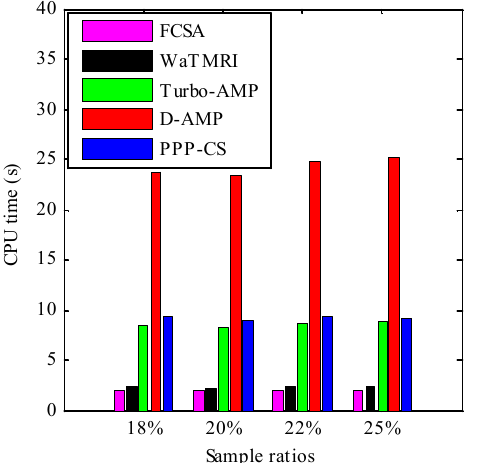
Figure 4. Average CPU time (s) comparisons on the 12 test images with various sampling ratios.